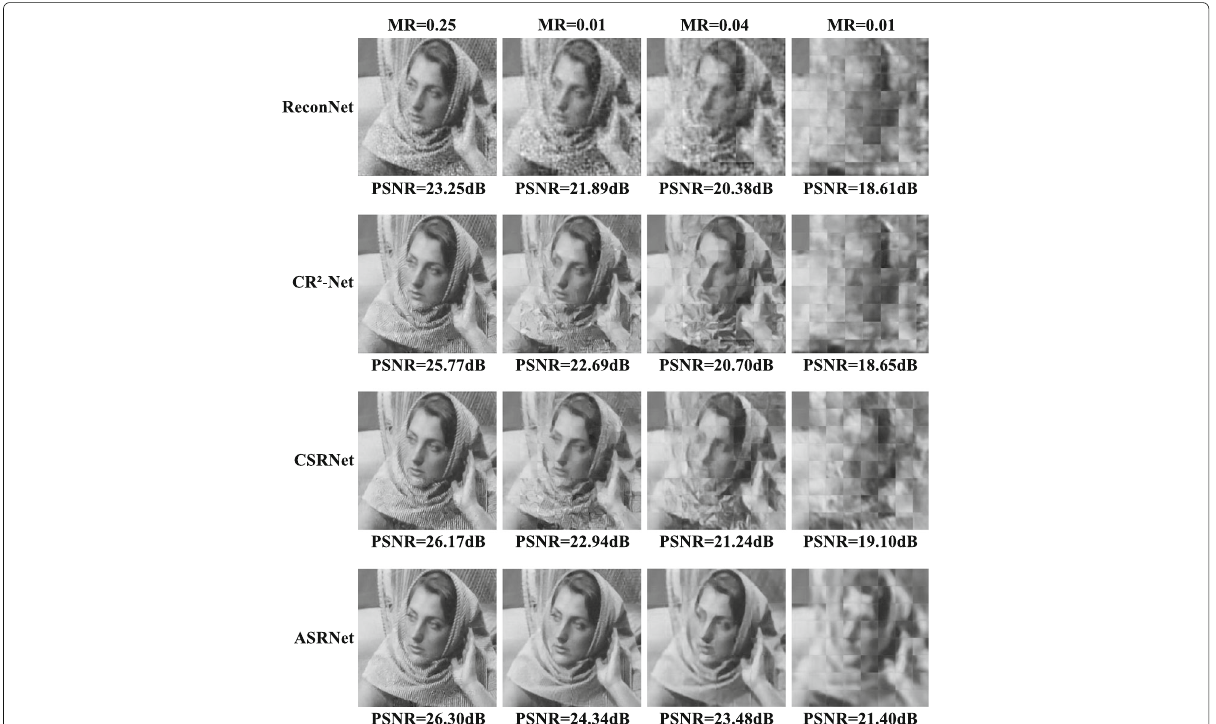
Fig. 13 The reconstruction results of Barbara at the measurement rate of 0.25, 0.1, 0.04, and 0.01 without BM3D